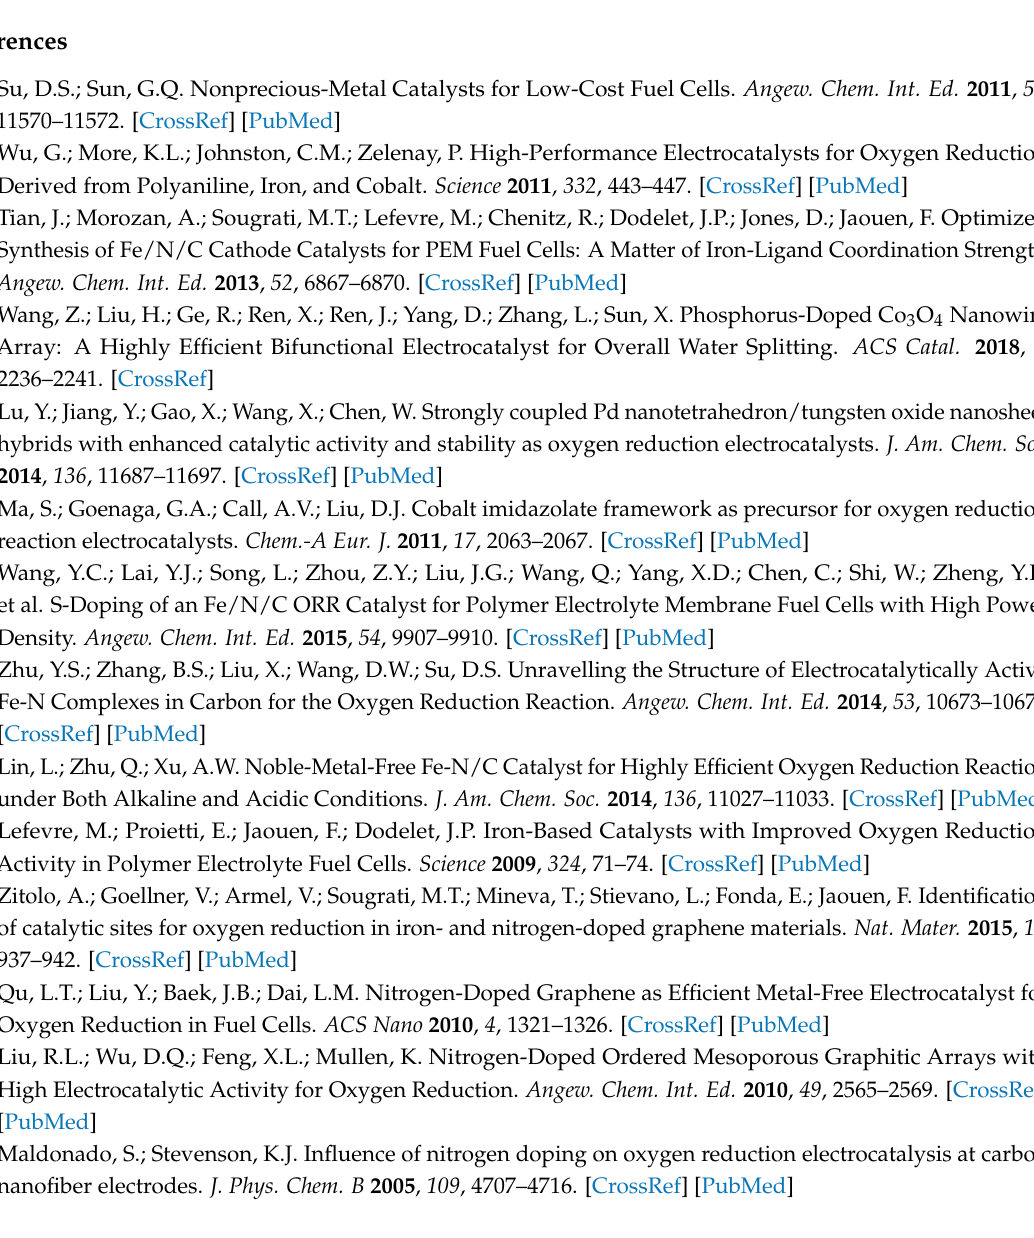
Figure S1: XPS spectra of C 1s (a) and S 2p (b) for Fe-N/Fe3C/Fe/C-800, Figure S2: Linear sweeping voltammograms for oxygen reduction reaction at 1600 rpm. (a) Ligand-800, S-Ligand-800, and Fe-N/Fe 3 C/Fe/C-800 in 0.1 M KOH. (b) Ligand-800, S-Ligand-800, and Fe-N/Fe 3 C/Fe/C-800 in 0.1 M HClO 4 . (c) Fe-N/Fe 3 C/Fe/C catalysts with different pyrolyzing temperatures in 0.1 M KOH. (d) Fe-N/Fe 3 C/Fe/C catalysts with different pyrolyzing temperatures in 0.1 M HClO 4 , Figure S3: (a), (b) Rotating ring-disk electrode voltammogram of Fe-N/Fe 3 C/Fe/C-800 in O 2 -saturated 0.1 M KOH and 0.1 M HClO 4 at 1600 rpm, respectively. (c) The electron transfer number (n) of Fe-N/Fe 3 C/Fe/C-800 at different potentials and percentage of peroxide with respect to the total oxygen reduction products in 0.1 M KOH and 0.1 M HClO 4 ,